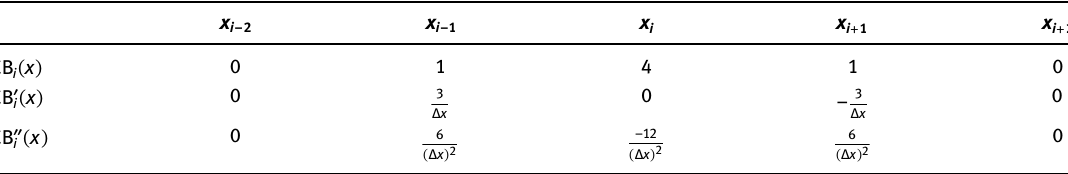
Table 1: The values of cubic B - spline functions and its derivatives at the knots x i −2 x i −1 x i + x i 1 + x i